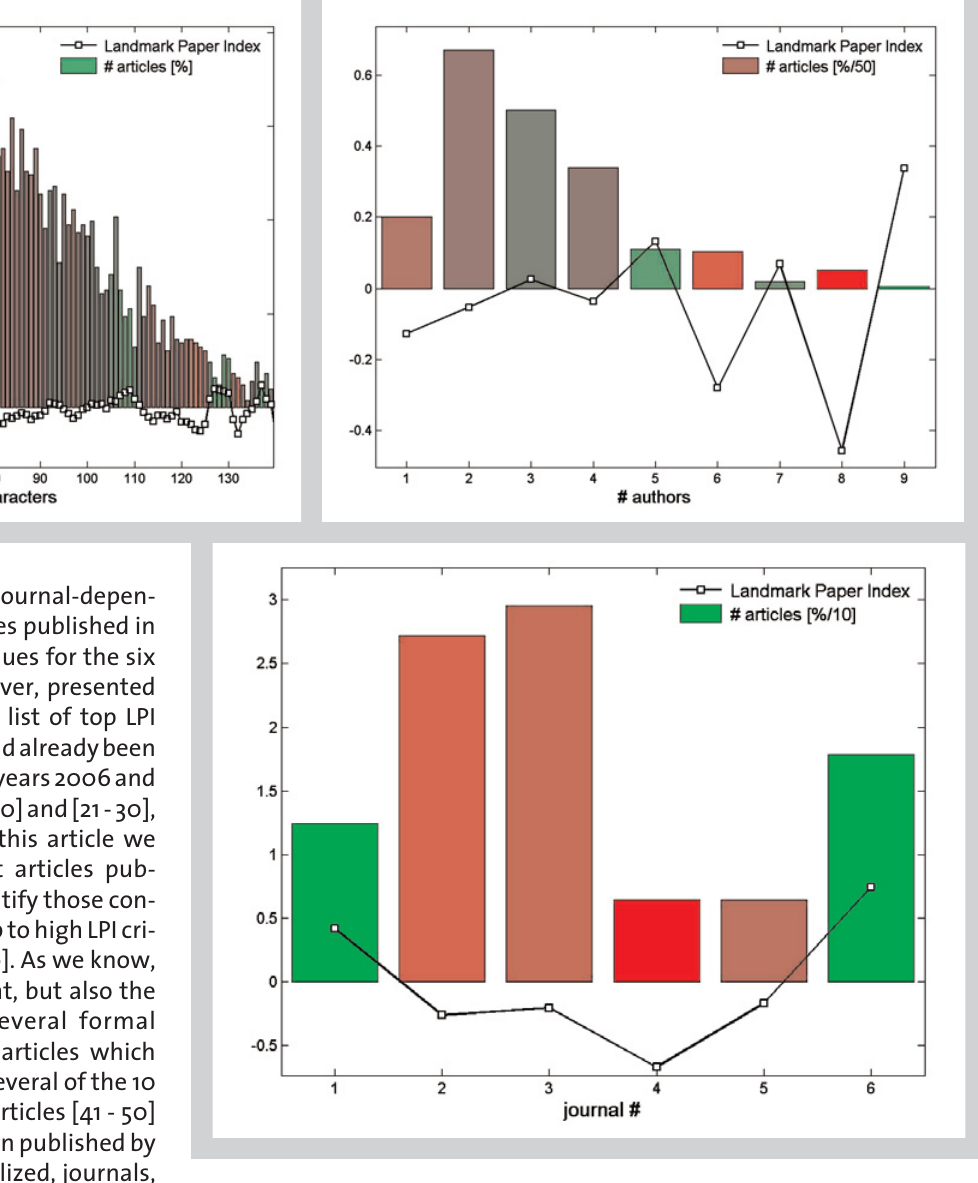
Figure 7 (left above): Number of characters in the title versus LPI. Figure 8 (right above): Number of authors and their correlation with the LPI. Figure 9 (below): LPI evaluated for all articles published in 2006, shown are mean values for six h - journals in undisclosed